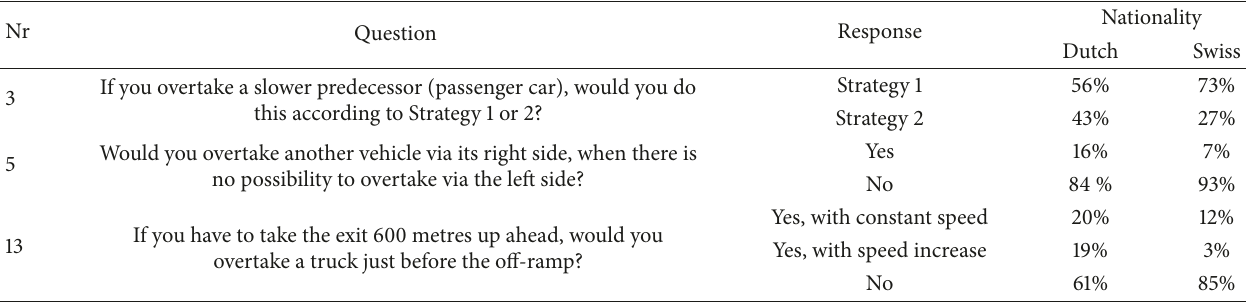
Table 5: Comparison of responses of Dutch and Swiss drivers for scenarios 3, 5, and